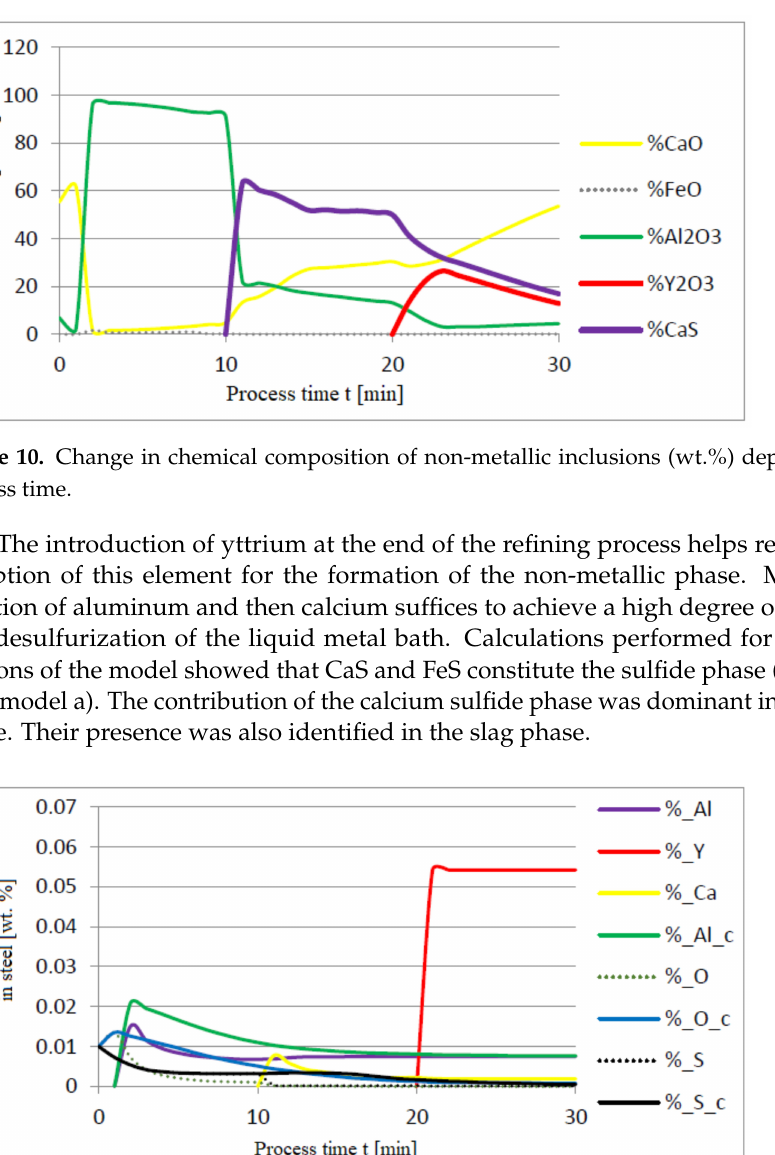
Figure 9. Change in chemical composition of slag (wt.%) depending on the process time (min).